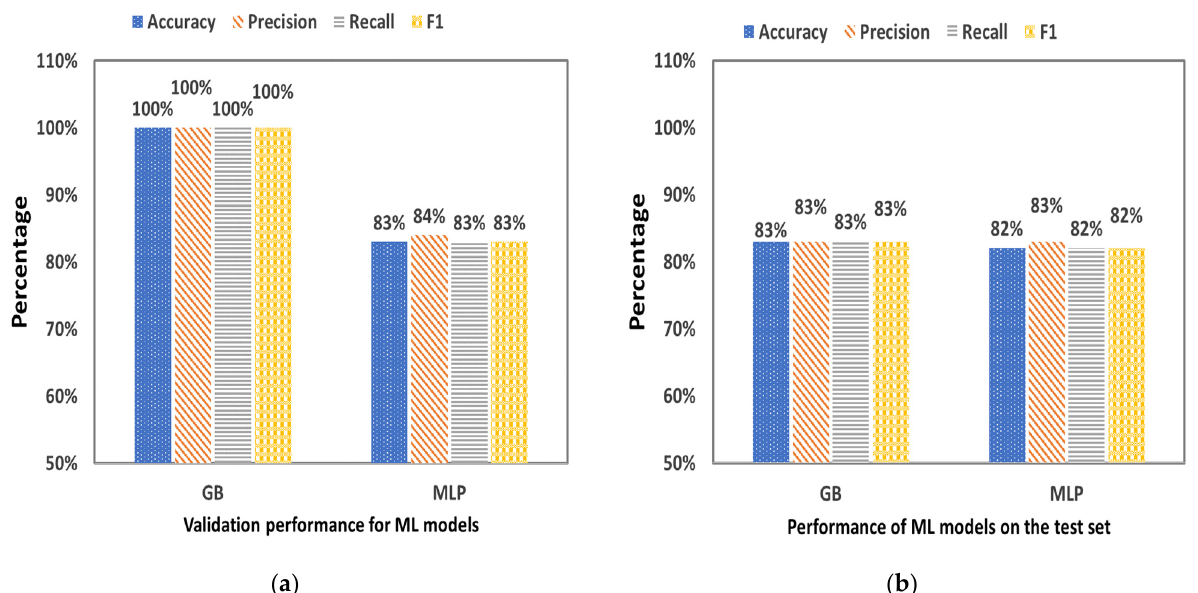
Figure 10. Statistical criteria that resulted from ( a ) the validation (training sample 11,062) and ( b ) the performance (testing sample 2765) of GB and MLP algorithm in the RUN 2. Table 2. The predicted category of the samples of each treatment for GB and MLP algorithm in the RUN 2 test process (of testing sample 2765).